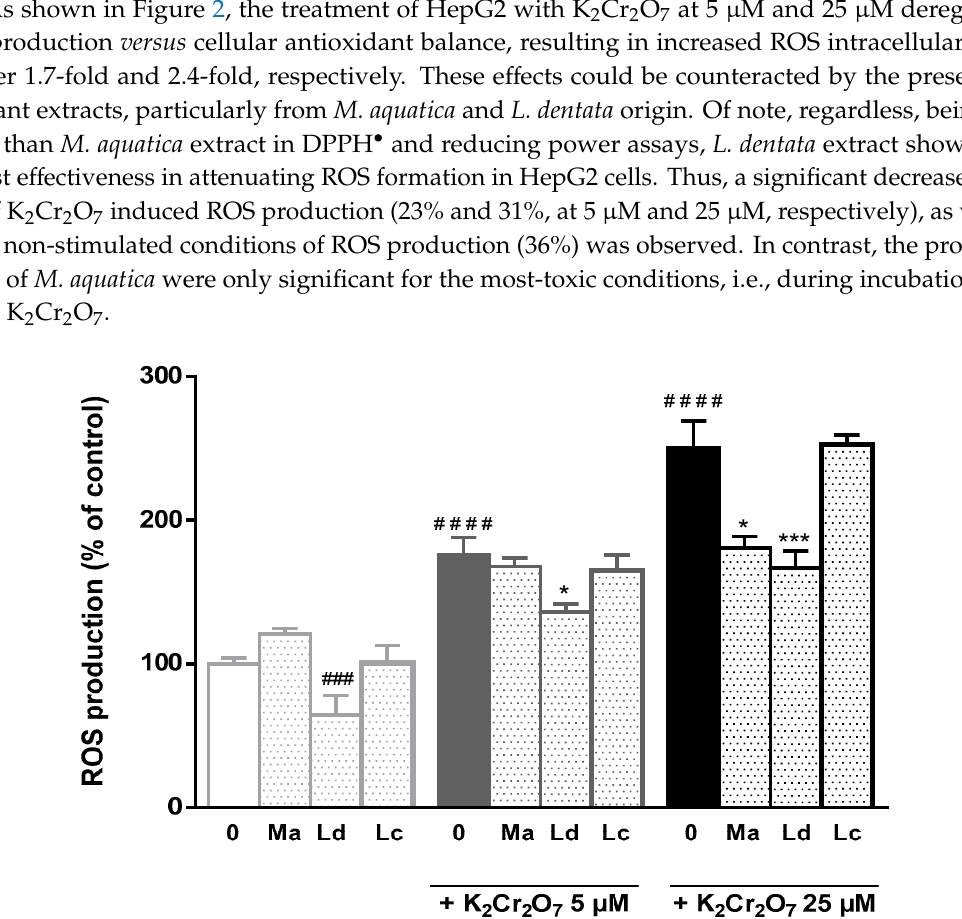
Figure 2. Effect of M. aquatica , L. dentata and L. cardiaca hydroethanolic extracts (at 50 μ g/mL) in ROS production in HepG2 cells in the absence or presence of 5 or 25 μ M of potassium dichromate. Values are expressed as means ± S.D. of percentage of ROS production with respect to the control (untreated cells). K 2 Cr 2 O 7 , potassium dichromate; Ma, M. aquatica extract; Ld, L. dentata extract; Lc, L. cardiaca extract.